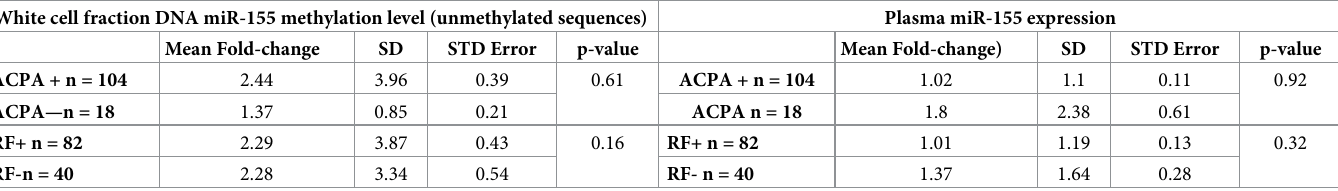
Table 3. Methylation level of miR-155 gene (shown as unmethylated sequences) and miR-155 plasma expression in RA patients according ACPA and RF positivity. White cell fraction DNA miR-155 methylation level (unmethylated sequences)